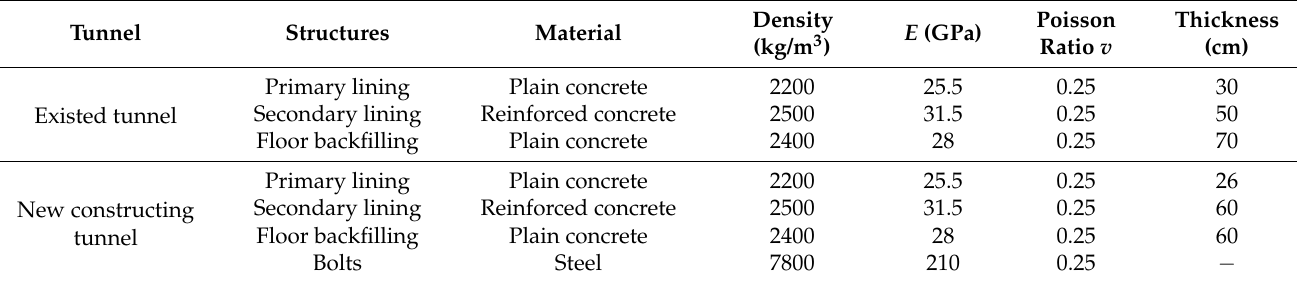
Table 3. Material properties of support